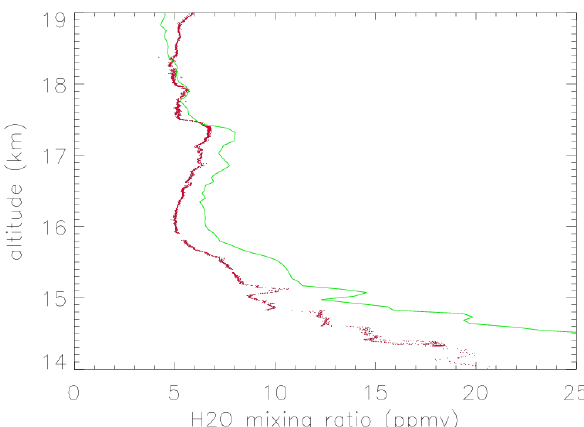
Fig. 1 Fig. 1. UTLS water vapour profiles from Balloon-borne micro- SDLA (red line) and FLASH-B (green) measurements from Ni- amey at 18:40 and 18:52 UT (launch time) on 5 August 2006, re-